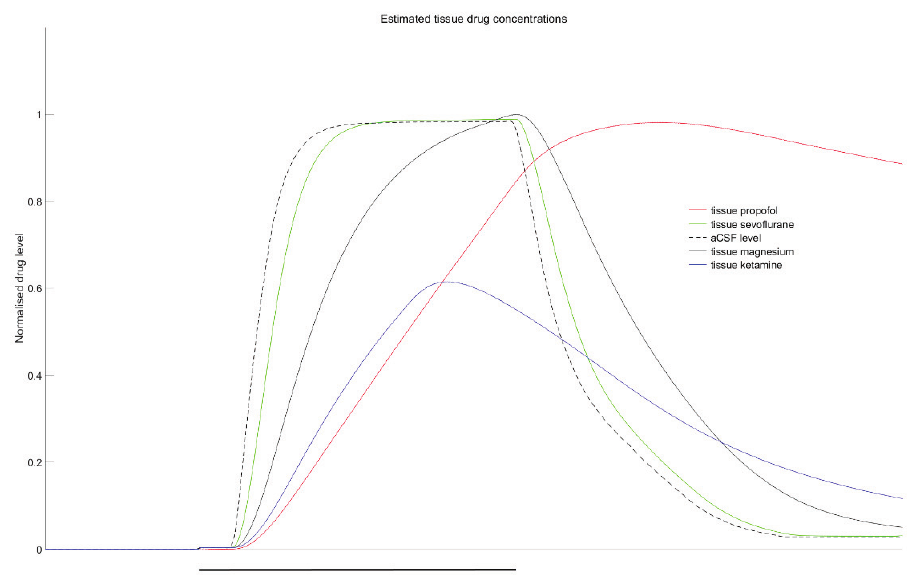
Figure 3. Normalized time course estimates for drug movement into and out of the tissue slices. The dotted black line indicates the aCSF drug level time course for a 15-min wash-in (note that the ketamine wash-in period was only 10 min). The tissue levels were estimated by applying an effect-site compartment and inhibitory E max model describing the relationship between drug concentration and seizure-like event frequency (see [19] for details).